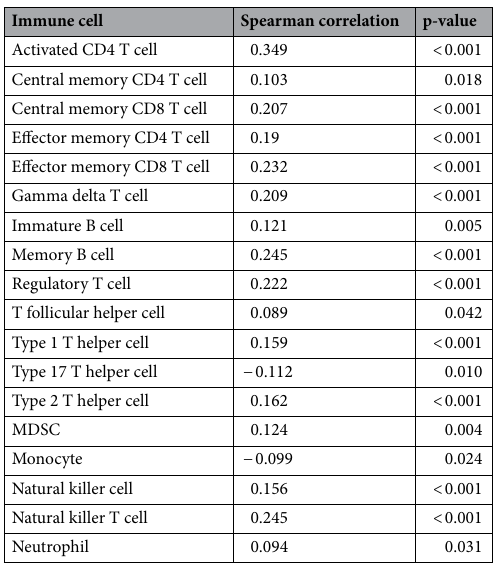
Table 3. The association between the expression level of GREB1L and the immune infiltration in the tumor